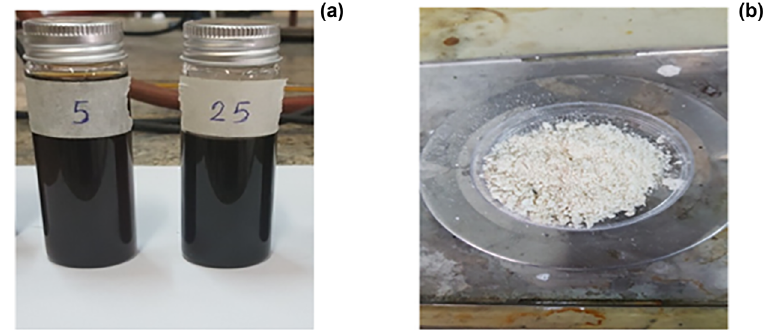
Figure 1: Walnut leaf extract ( a ) and synthesized ZnO NPs ( b )